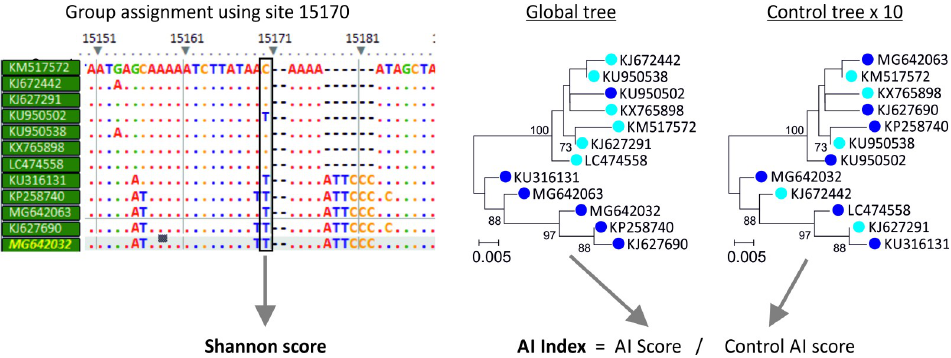
Fig 6. Using the association index to determine informativeness of individual sites. Schematic summary of the steps used to investigate site informativeness. Individual alignment positions are sequentially analysed for their concordance to a global phylogeny. Base identity is used to assign groups which are then use for calculation of an association value through group segregation in a neighbour-joining tree of the alignment where non-bootstrap supported branches are collapsed. The AI index is its ratio to the mean association value of 10 sequence label order randomised controls (representing the null expectation of no association). Finally, the Shannon entropy score, representing site heterogeneity is